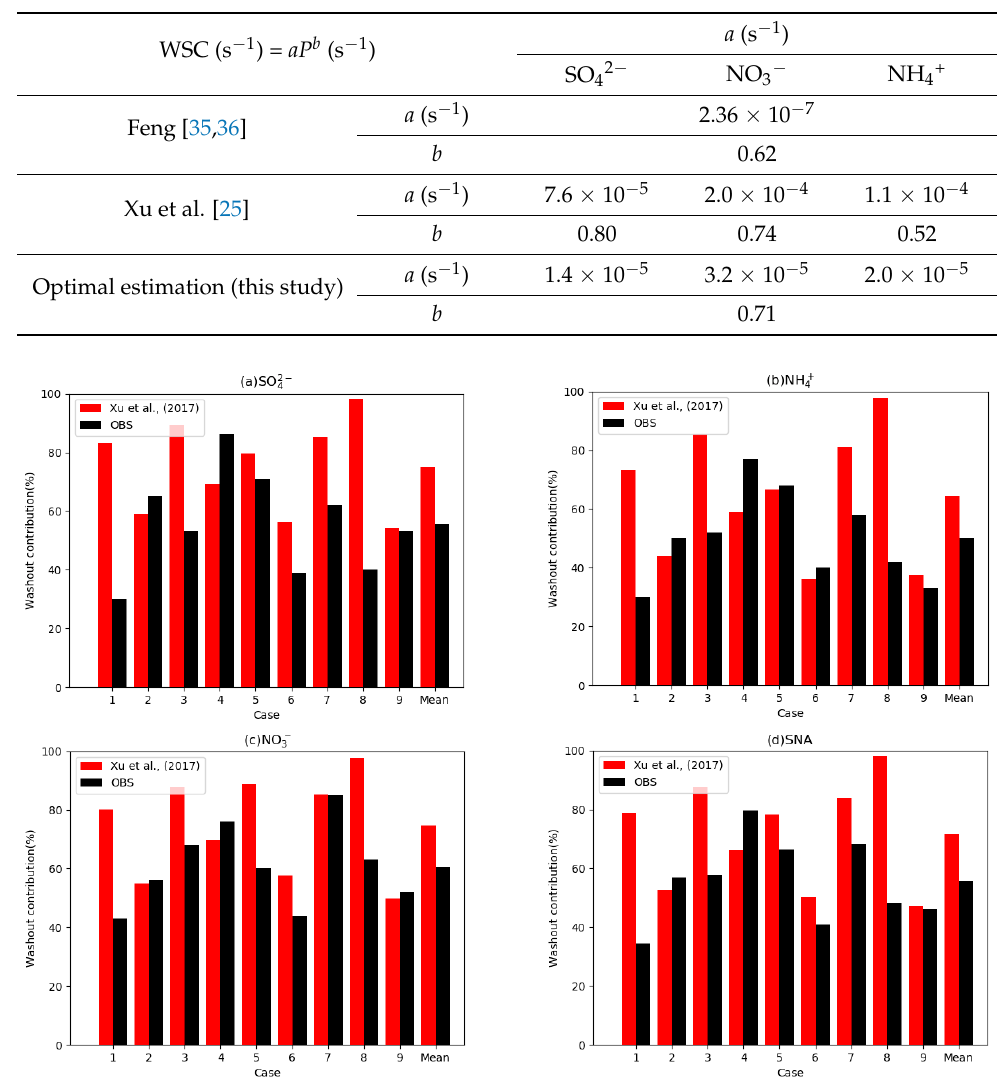
Table 5. Wet scavenging coefficient (WSC) values used in this study for simulations.